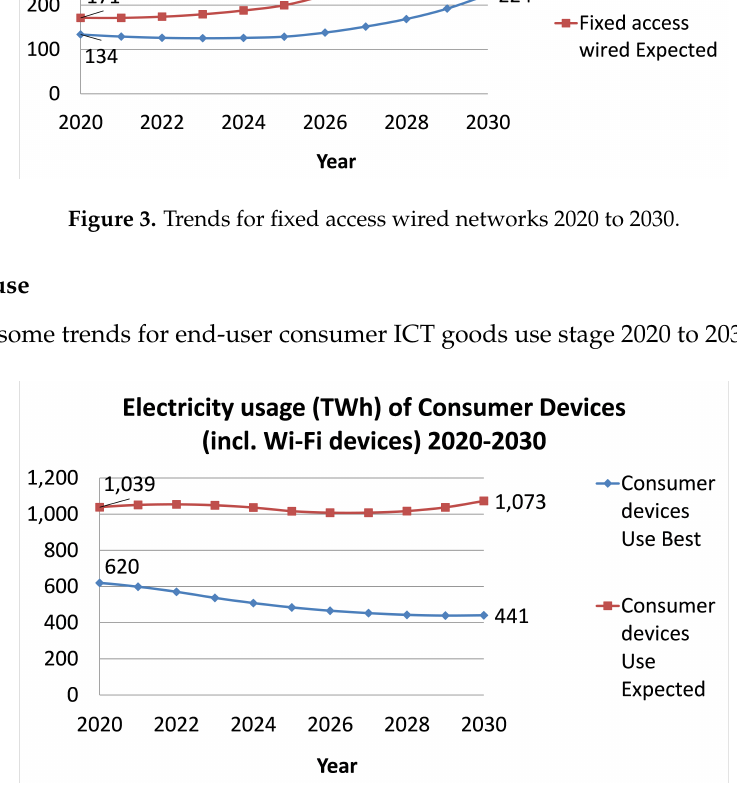
Figure 4. Trends for consumer ICT goods use stage 2020 to